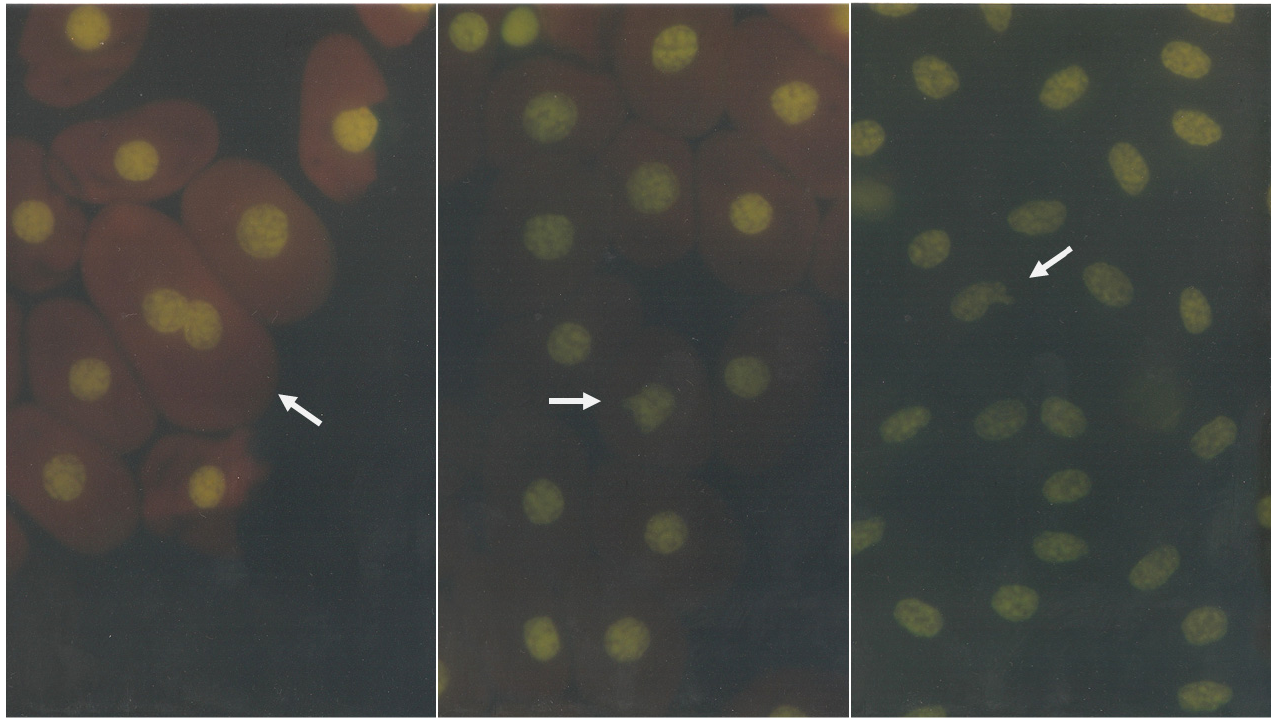
Figure 4. Erythrocytes with nuclear abnormalities in peripheral blood samples from reptiles were observed. Left shows a binucleated cell from a turtle; center shows a nuclear bud from a turtle; and right shows a nuclear bud from a rattlesnake. In crocodiles, the formation of NBEs, as well as MNEs, could be induced due to the effect observed in nucleated peripheral blood erythrocytes when exposed to two different doses of CP every 24 h for two days. In the case of MNEs, increased numbers of these structures were observed in the study groups exposed to one of the two doses of CP compared to the baseline value, and these increases were significant in the group that received CP at a dose of 7